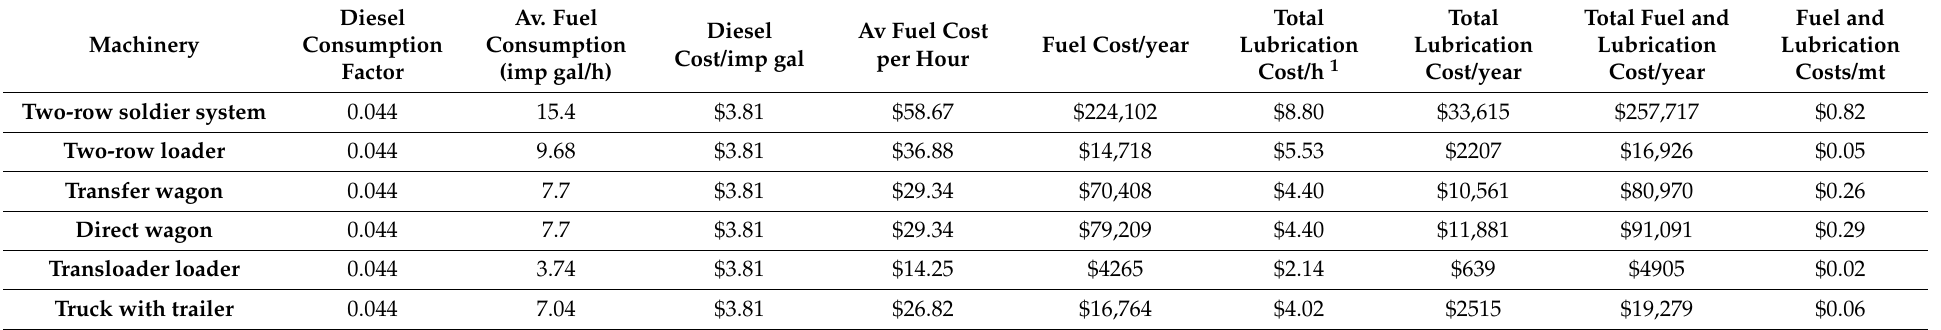
Table 8. The estimated fuel and lubricant costs for harvesting and transportation